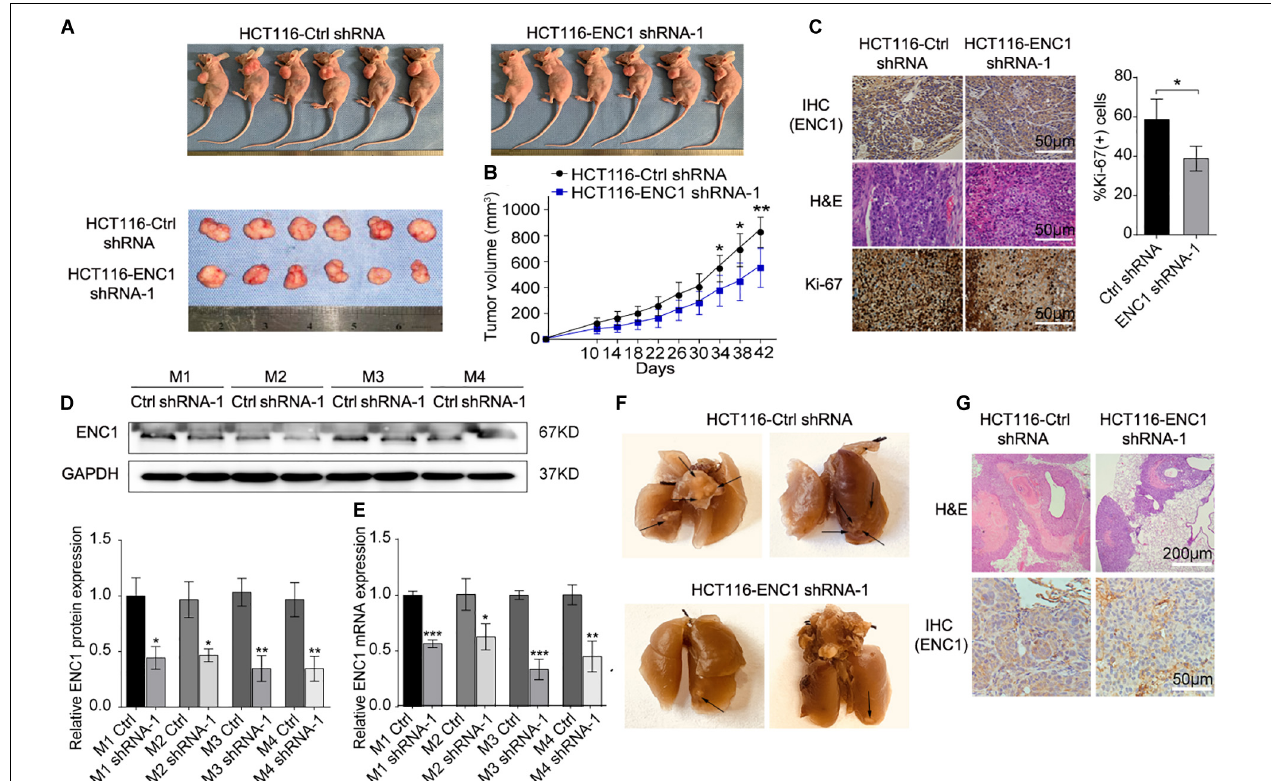
FIGURE 4 | In vivo , downregulation of ENC1 inhibits xenograft tumor growth and lung metastasis. (A) Images of xenograft tumors from six BALB/c nude mice at 42 days after subcutaneously inoculated with HCT116-Ctrl shRNA and HCT116-ENC1 shRNA-1 cells. (B) The growth of xenograft tumors was measured by tumor volume every 4 days and tumor growth curves were plotted between the comparison in two groups ( n = 6). (C) Representative images of IHC and H&E staining show that ENC1 silencing downregulated the expression of ENC1 and Ki-67 in xenograft tumors (magnification × 400, scale bar = 50 µ m). The protein and mRNA levels of ENC1 were also analyzed in xenograft tumor tissues by Western blotting (D) and qRT-PCR (E) , respectively. (F) Representative images of metastatic lungs in the HCT116-Ctrl shRNA (left) group and HCT116-ENC1 shRNA-1 (right) group. Black arrows indicated the metastatic pulmonary nodules. (G) H&E staining (upper panel: magnification × 100, scale bar = 200 µ m) and IHC staining with ENC1 (lower panel: magnification × 400, scale bar = 50 µ m) were performed on section of metastatic pulmonary nodules. Results are presented as the mean ± SD of three independent experiments. Student’s t test was applied for statistical analysis in two-group comparison: * P < 0.05, ** P < 0.01, and *** P <